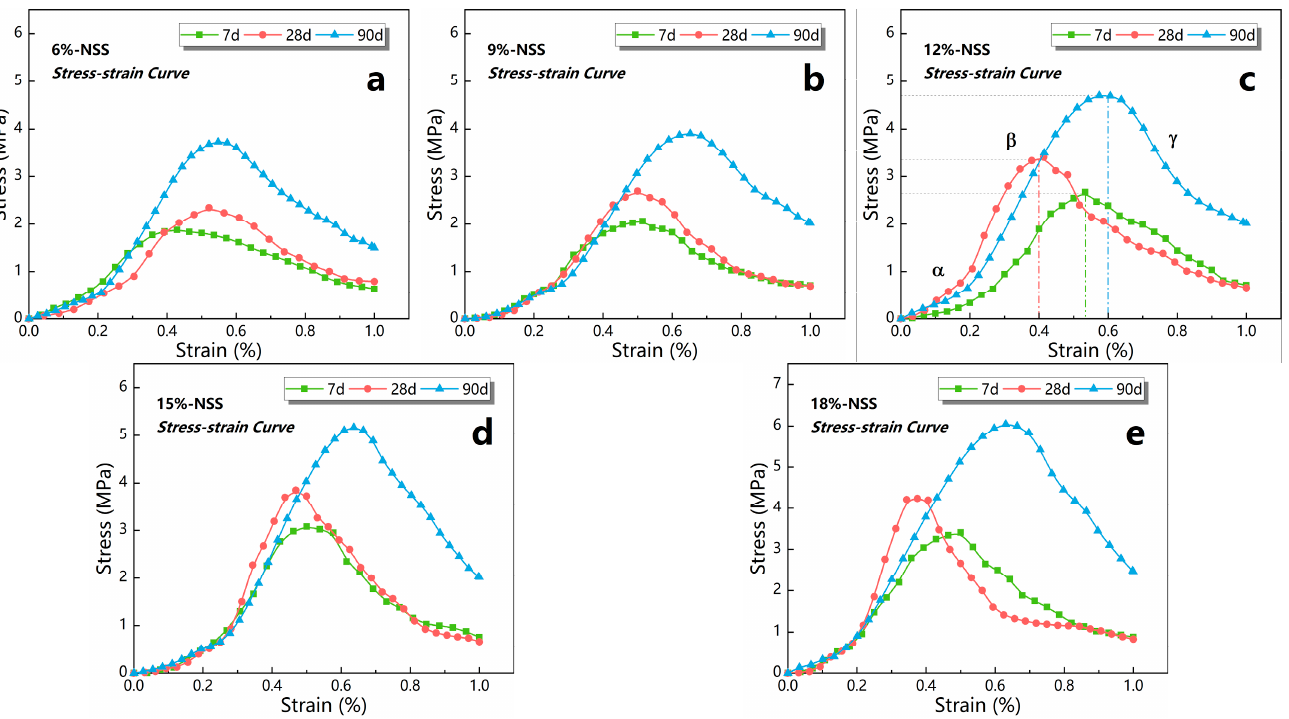
Figure 5. Stress–strain curves of NSS under different dosage at different curing periods. ( a ) Stress– strain curves of NSS under a 6% dosage; ( b ) stress–strain curves of NSS under a 9% dosage; ( c ) stress–strain curves of NSS under a 12% dosage; ( d ) stress–strain curves of NSS under a 15% dosage; ( e ) stress–strain curves of NSS under a 18% dosage.